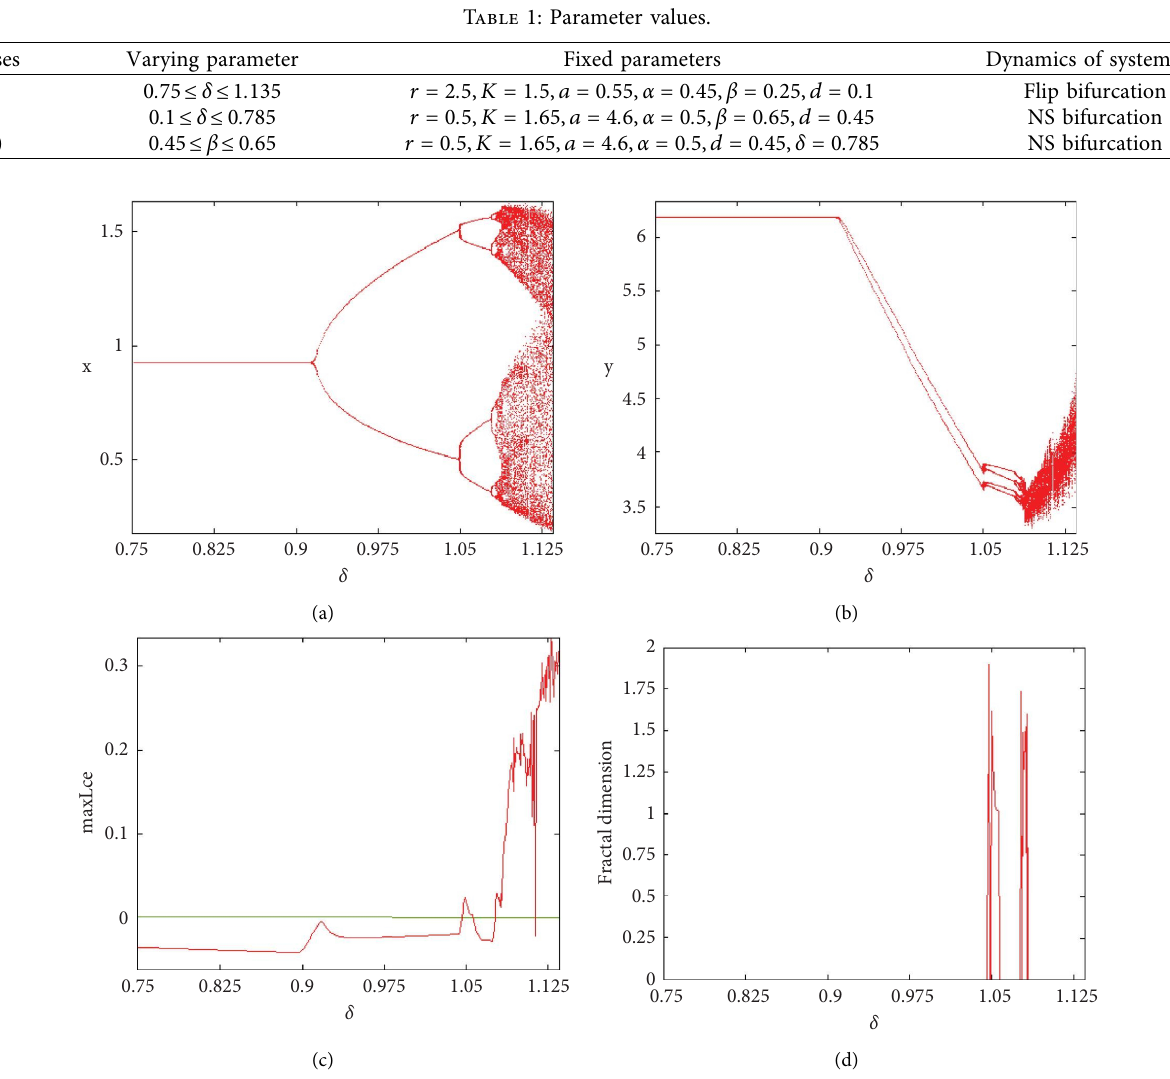
Figure 2: Flip bifurcation diagrams of system (4) for δ : (a) in prey, (b) in predator, (c) MLEs, and (d)